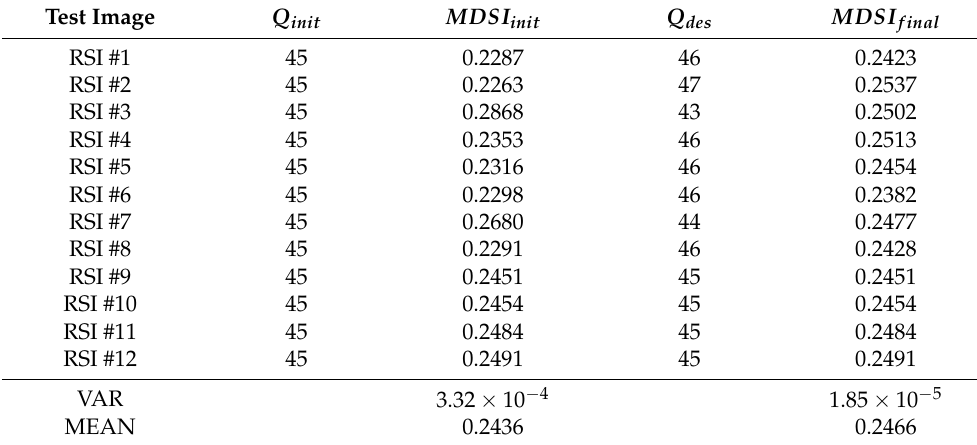
Table A6. The experimental data obtained for the basic image set for the desired MDSI = 0.25.